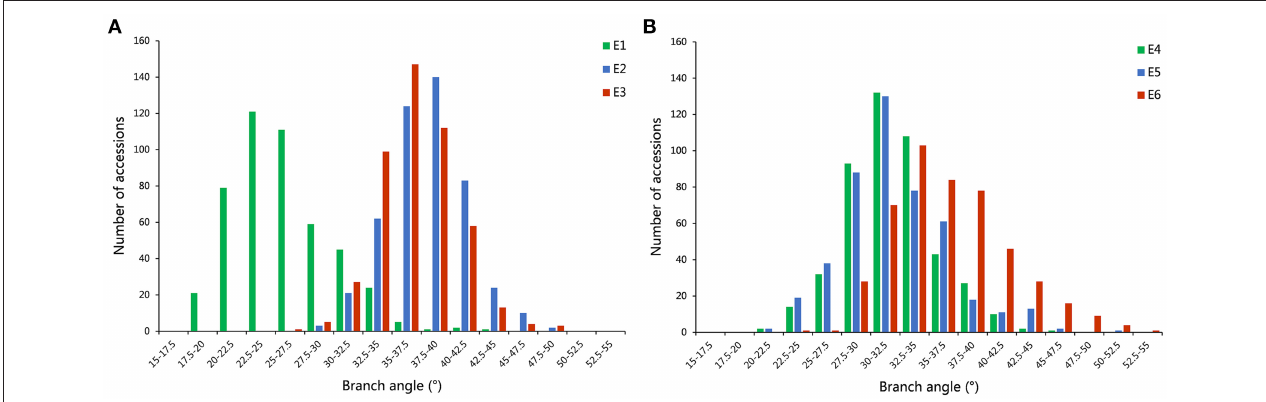
FIGURE 2 | The distribution of branch angle across 472 rapeseed accessions in six environments. (A) The environments of E1, E2, and E3. (B) The environments of E4, E5, and E6.